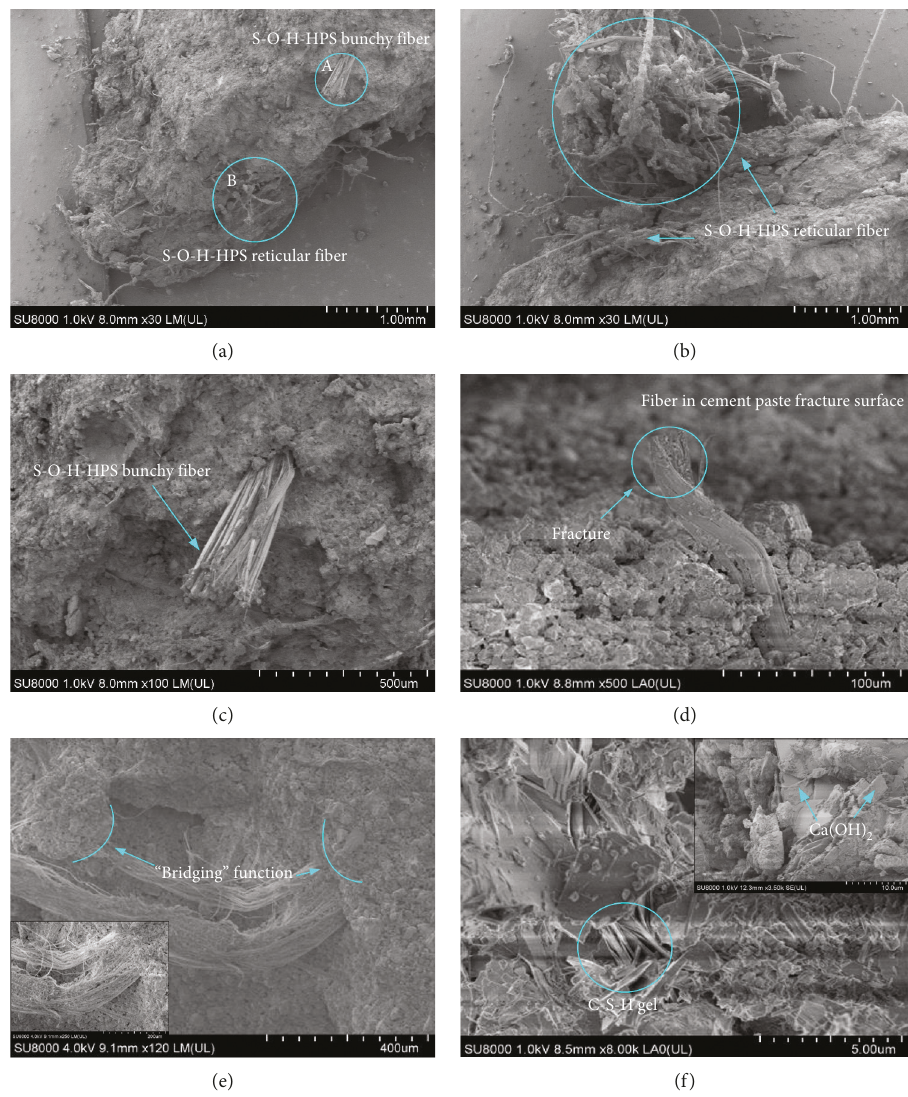
Figure 13: Micromechanism of sulfonated sepiolite